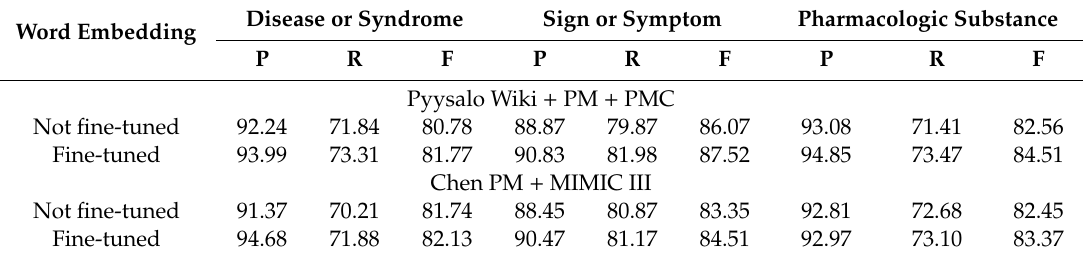
Table 9. Impact of fine-tuning embeddings of BiLSTM-CRF (word + char + POS)